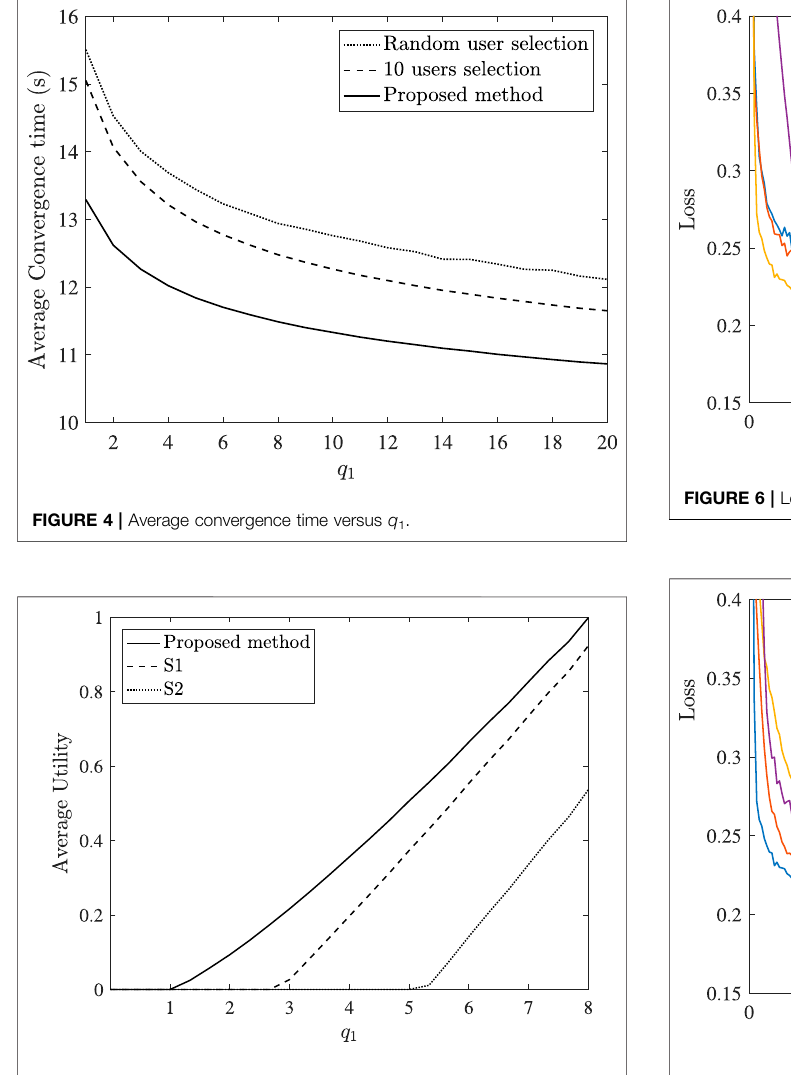
FIGURE 7 | Batch size selection.